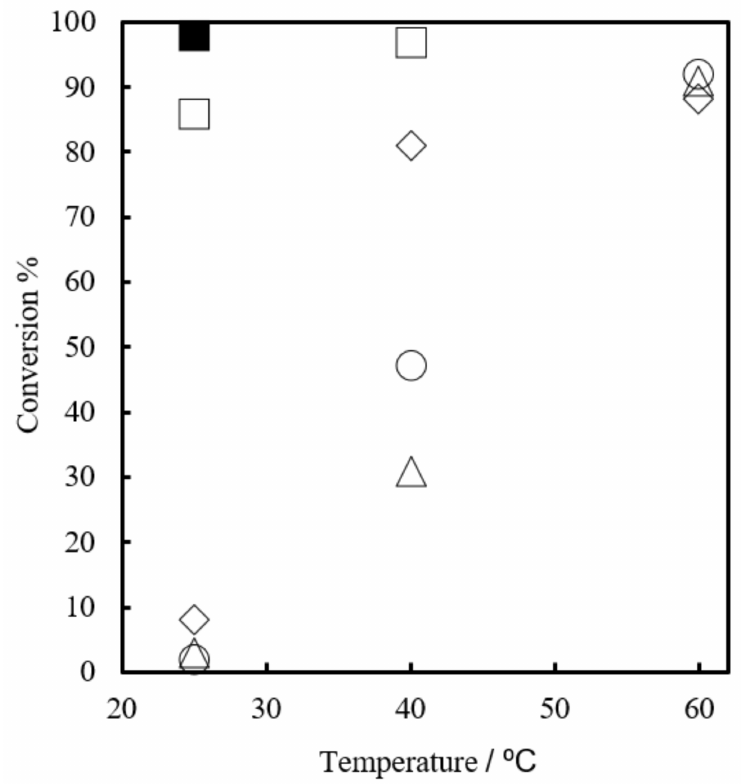
Figure 3. The conversion of phenol after 30 min as a function of temperature during reaction with SA-102 ( (cid:4) ), α -ZrP · 0.58DBU ( (cid:3) ), α -ZrP · 0.44DBU ( ), α -ZrP · 0.22DBU ( (cid:52) ), and α -ZrP · 0.10DBU ( ). (cid:51) (cid:35) The pot lifetimes for the α -ZrP · DBU compounds were evaluated at 25 ◦ C as shown in Figure 4. The pot lifetimes at 25 ◦ C for the SA-102 and α -ZrP · 0.58DBU catalysts were not determined. The conversion was 24% with α -ZrP · 0.44DBU at 25 ◦ C for 1 h. The conversions with α -ZrP · 0.22DBU and α -ZrP · 0.10DBU were 22% and 18% at 25 ◦ C for 2 h. These catalysts could extend the pot lifetime at 25 ◦ C. The conversion with α -ZrP · 0.44DBU for 1.5 h was 36% and with α -ZrP · 0.22DBU and α -ZrP · 0.10DBU were 55% and 35% for 4 h. The pot life for 30% conversion was over 1.5 h for α -ZrP · 0.44DBU and 4 h for α -ZrP · 0.22DBU